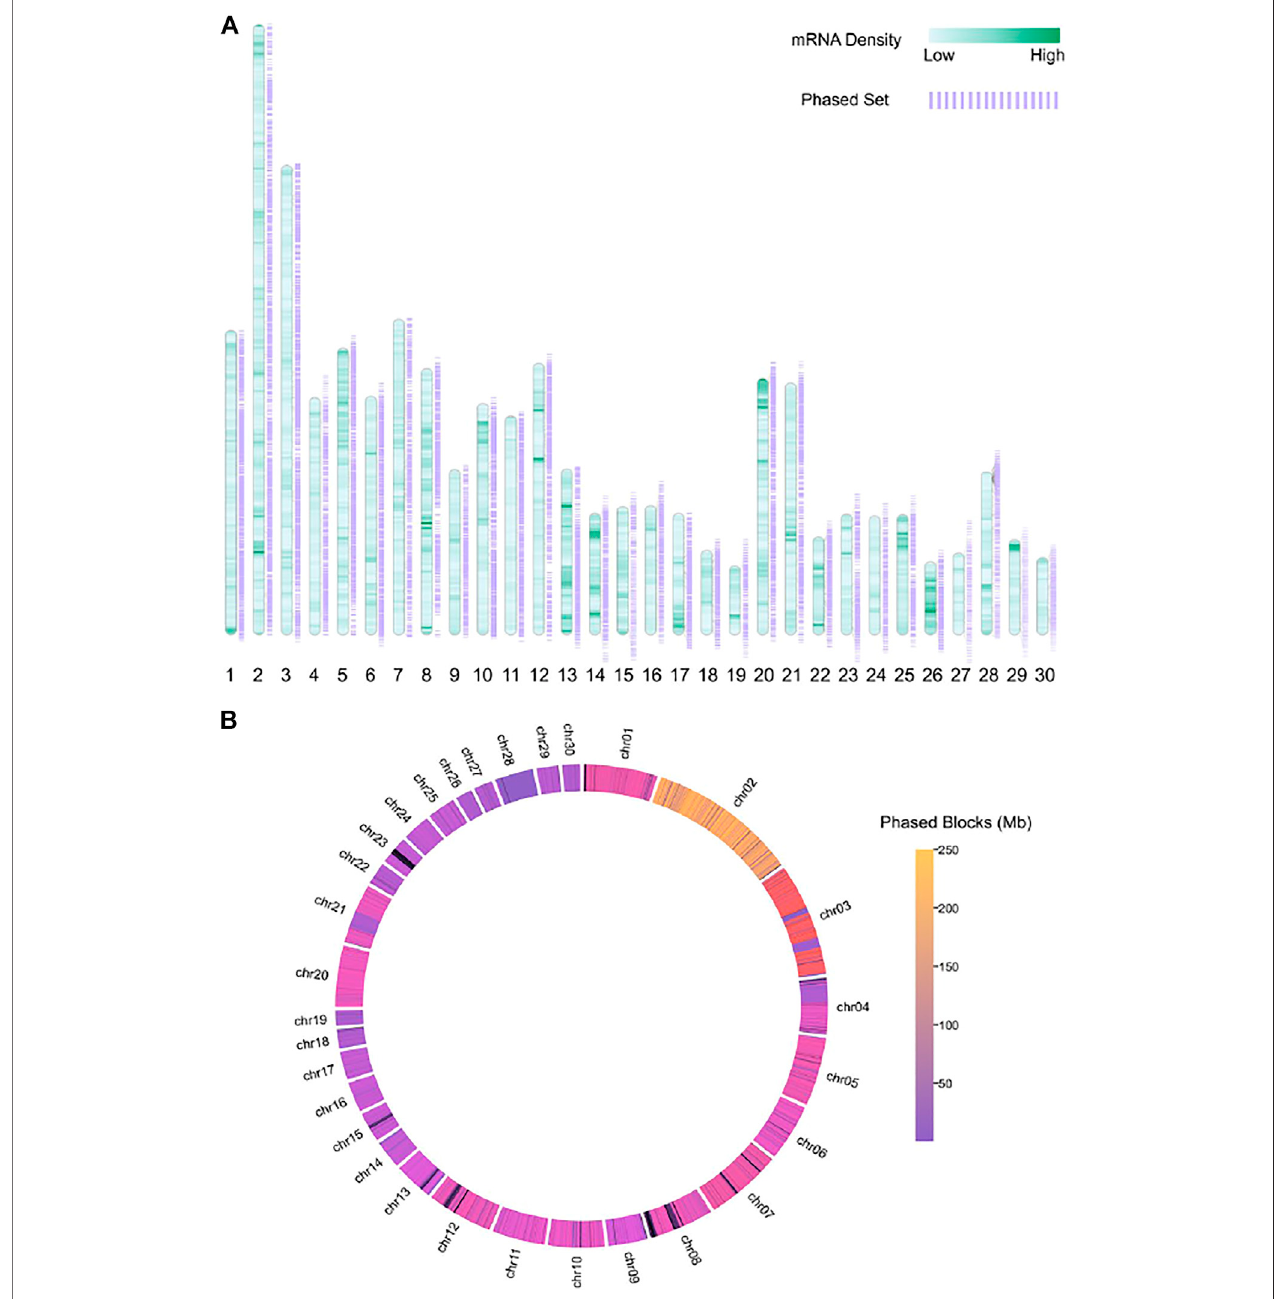
FIGURE6| FiguresshowthedensityofmRNAandthechromosome-levelphasesetforasingleindividualdonkey,differentcolorsshowthe (A) mRNAdensityand (B) phased block(Mb).